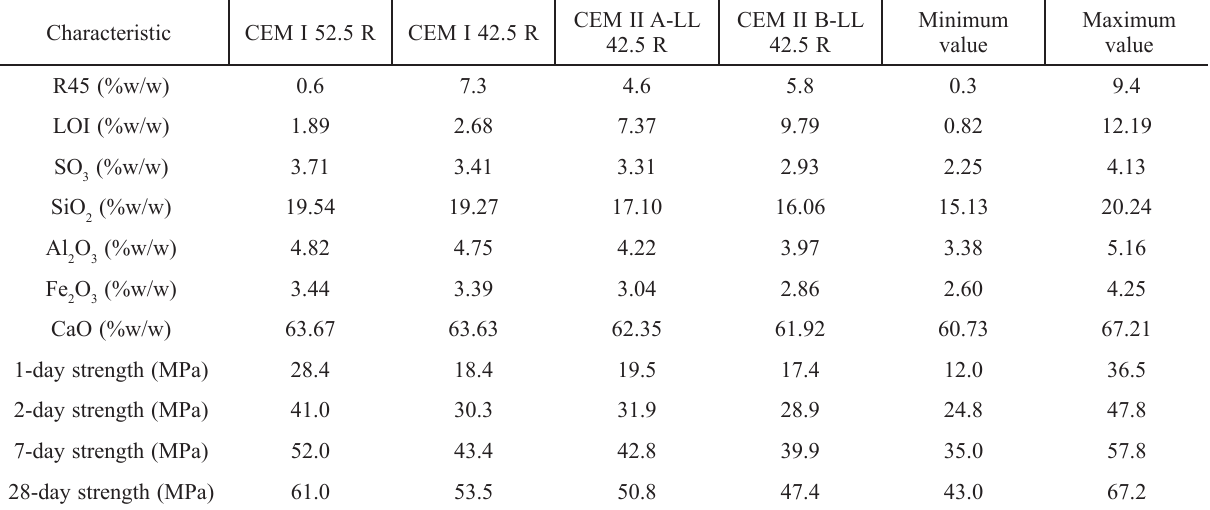
Table 3 – Average values of cements characteristics